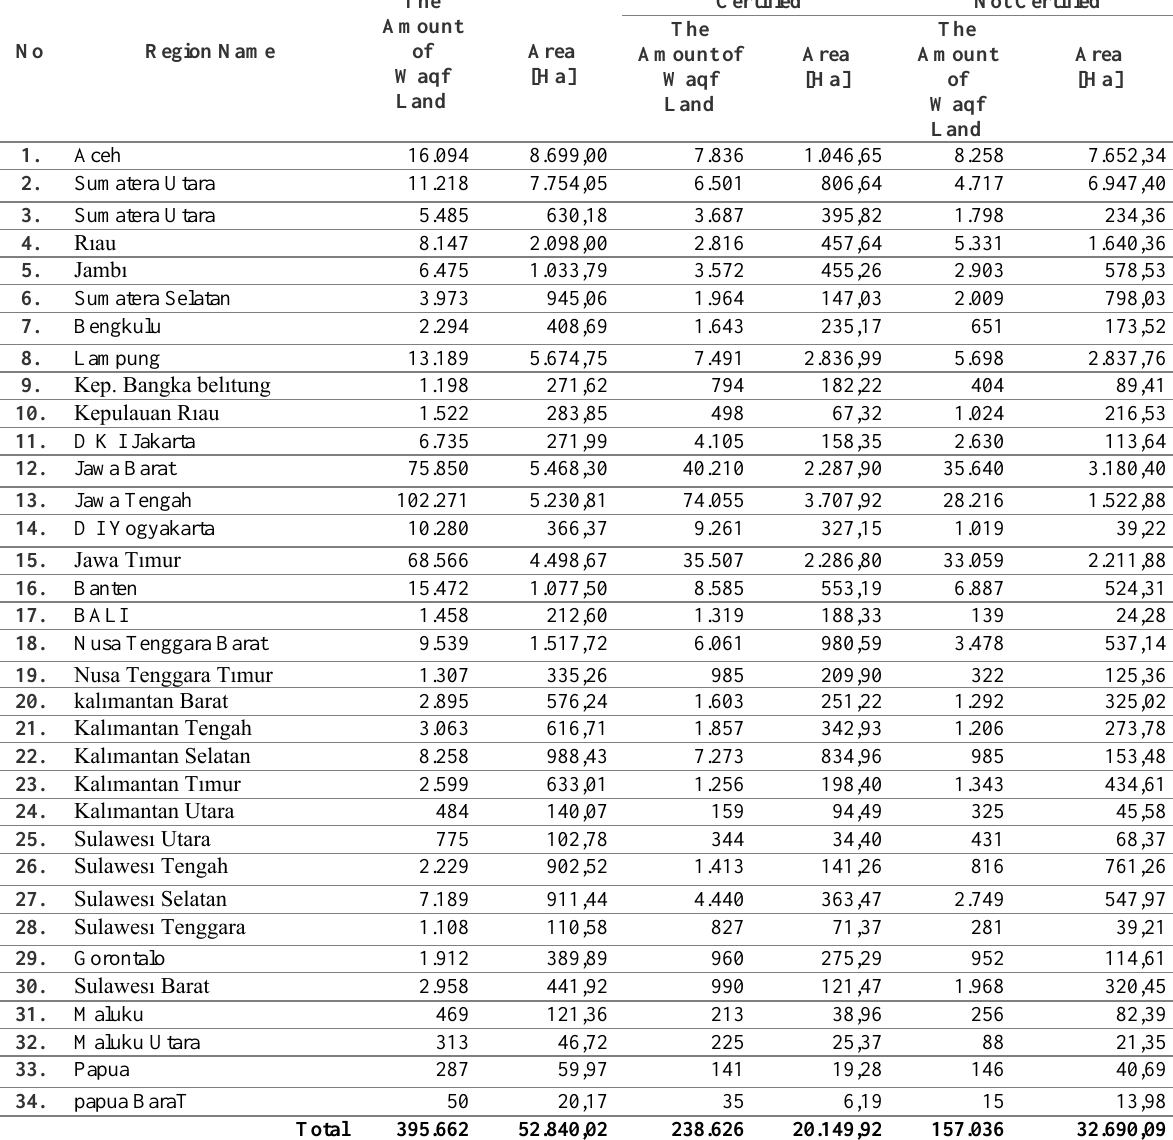
Table 1: Land of Waqf throughout